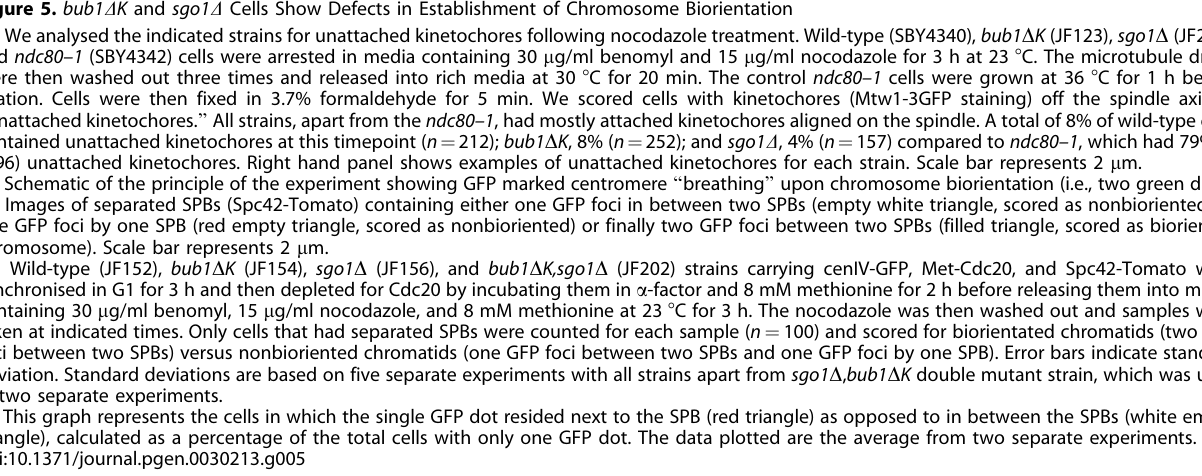
Figure 5. bub1 D K and sgo1 D Cells Show Defects in Establishment of Chromosome Biorientation (A) We analysed the indicated strains for unattached kinetochores following nocodazole treatment. Wild-type (SBY4340), bub1 D K (JF123), sgo1 D (JF202), and ndc80–1 (SBY4342) cells were arrested in media containing 30 l g/ml benomyl and 15 l g/ml nocodazole for 3 h at 23 8 C. The microtubule drugs were then washed out three times and released into rich media at 30 8 C for 20 min. The control ndc80–1 cells were grown at 36 8 C for 1 h before fixation. Cells were then fixed in 3.7% formaldehyde for 5 min. We scored cells with kinetochores (Mtw1-3GFP staining) off the spindle axis as ‘‘ unattached kinetochores. ’’ All strains, apart from the ndc80–1 , had mostly attached kinetochores aligned on the spindle. A total of 8% of wild-type cells contained unattached kinetochores at this timepoint ( n ¼ 212); bub1 D K , 8% ( n ¼ 252); and sgo1 D , 4% ( n ¼ 157) compared to ndc80–1 , which had 79% ( n ¼ 96) unattached kinetochores. Right hand panel shows examples of unattached kinetochores for each strain. Scale bar represents 2 l m. (B) Schematic of the principle of the experiment showing GFP marked centromere ‘‘ breathing ’’ upon chromosome biorientation (i.e., two green dots). (C) Images of separated SPBs (Spc42-Tomato) containing either one GFP foci in between two SPBs (empty white triangle, scored as nonbioriented) or one GFP foci by one SPB (red empty triangle, scored as nonbioriented) or finally two GFP foci between two SPBs (filled triangle, scored as bioriented chromosome). Scale bar represents 2 l m. (D) Wild-type (JF152), bub1 D K (JF154), sgo1 D (JF156), and bub1 D K,sgo1 D (JF202) strains carrying cenIV-GFP, Met-Cdc20, and Spc42-Tomato were synchronised in G1 for 3 h and then depleted for Cdc20 by incubating them in a -factor and 8 mM methionine for 2 h before releasing them into media containing 30 l g/ml benomyl, 15 l g/ml nocodazole, and 8 mM methionine at 23 8 C for 3 h. The nocodazole was then washed out and samples were taken at indicated times. Only cells that had separated SPBs were counted for each sample ( n ¼ 100) and scored for biorientated chromatids (two GFP foci between two SPBs) versus nonbioriented chromatids (one GFP foci between two SPBs and one GFP foci by one SPB). Error bars indicate standard deviation. Standard deviations are based on five separate experiments with all strains apart from sgo1 D , bub1 D K double mutant strain, which was used in two separate experiments. (E) This graph represents the cells in which the single GFP dot resided next to the SPB (red triangle) as opposed to in between the SPBs (white empty triangle), calculated as a percentage of the total cells with only one GFP dot. The data plotted are the average from two separate